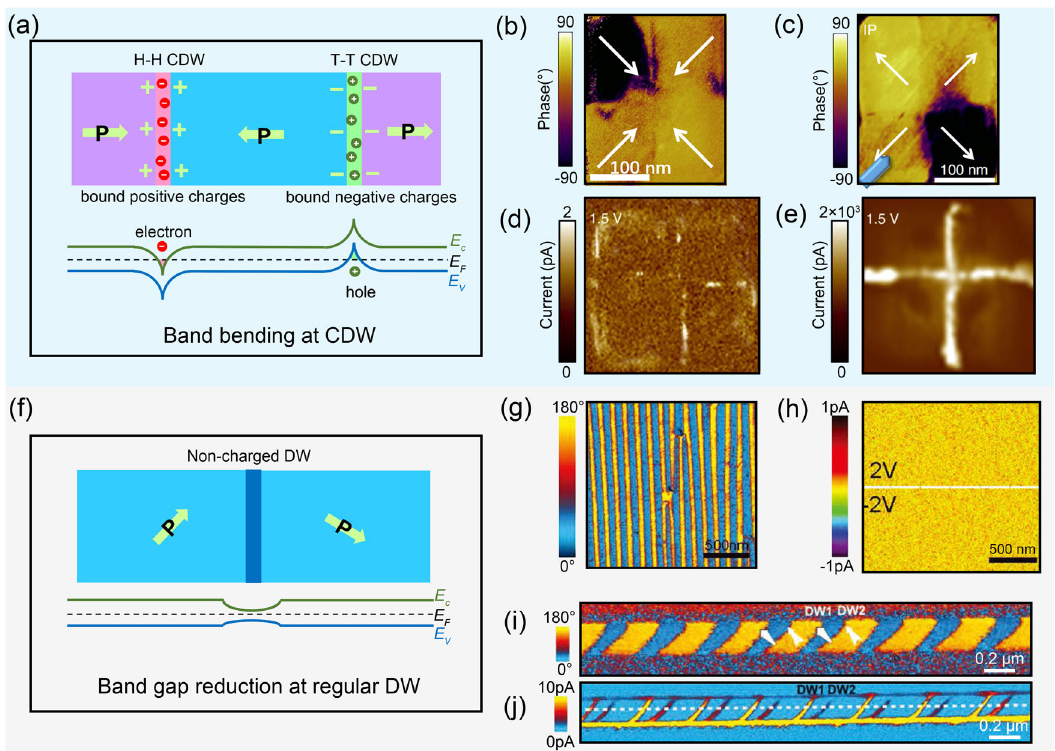
Fig. 6 Conductance of DWs. a – e The conductivity of charged DWs. a Mechanism of domain-wall conduction at charged DW originated by band bending. b In-plane (IP) PFM image of the BFO island at the initial state. The white arrows indicating the polarization directions in the center-convergent quad-domains. c The current map is under 1.5 V bias at the initial state. d In-plane (IP) PFM image of the BFO island after switching, which shows center-divergent quad-domain structur. e CAFM at the charged DWs under 1.5V bias after polarization switching of the nanoislands. The switched DWs show large conductivity. b - d are reproduced with permission from ref. [111]. Copyright [2018] {Springer Nature}. f - j Conductance at non-charged DWs. f Mechanism of conductance at non-charged DW originates from bandgap reduction. g , h The 71° DWs of BFO are insulated in the directions normal to the surface. g Lateral PFM phase image showing 71° DWs. h CAFM image of the same region in ( g ). i , j The 71° DWs of BFO are conductive in the direction parallel to the surface. i PFM image of BFO in a cross-section specimen with 71° DWs. The white arrows indicate the directions of polarization. j CAFM image of the same region in ( i ). g – j are reproduced with permission from ref. 134 . Copyright [2019] {John Wiley and